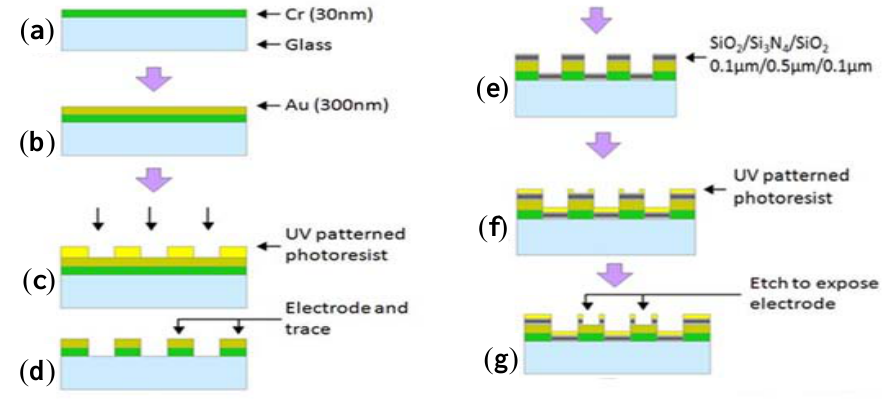
Figure 3. General fabrication process of MEA.